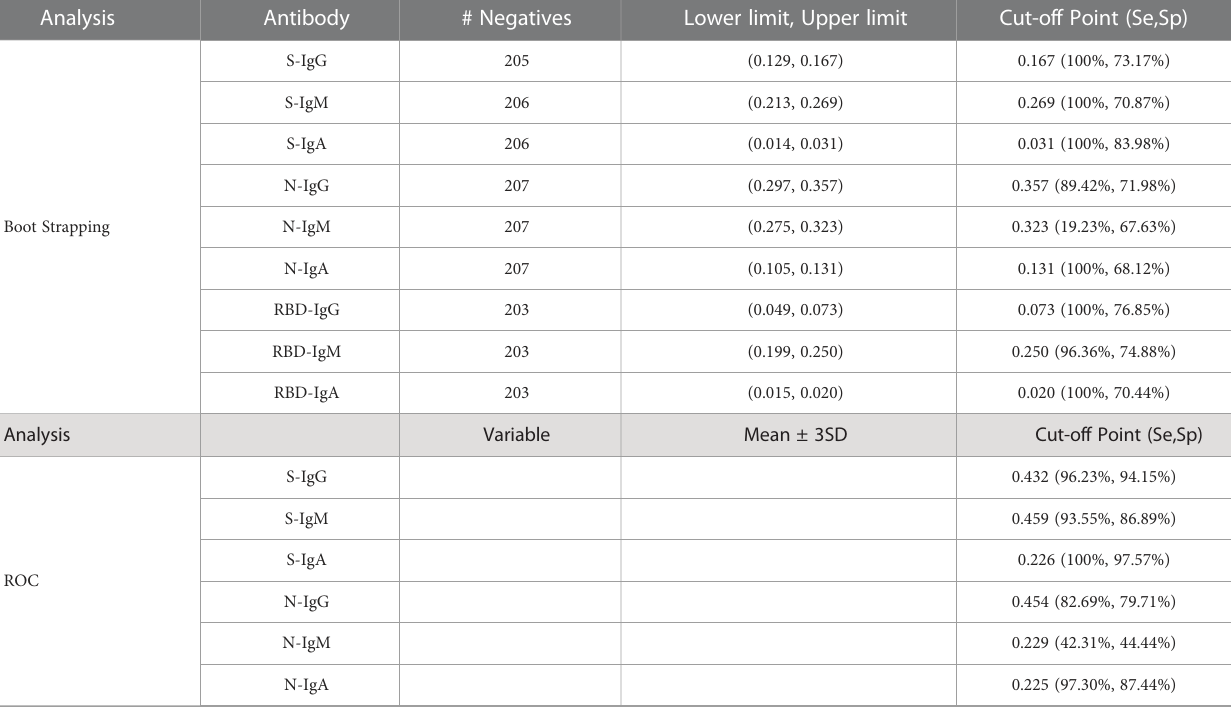
TABLE 5 Calculated Cut Off Points using Boot strapping, ROC and 4-Fold Above